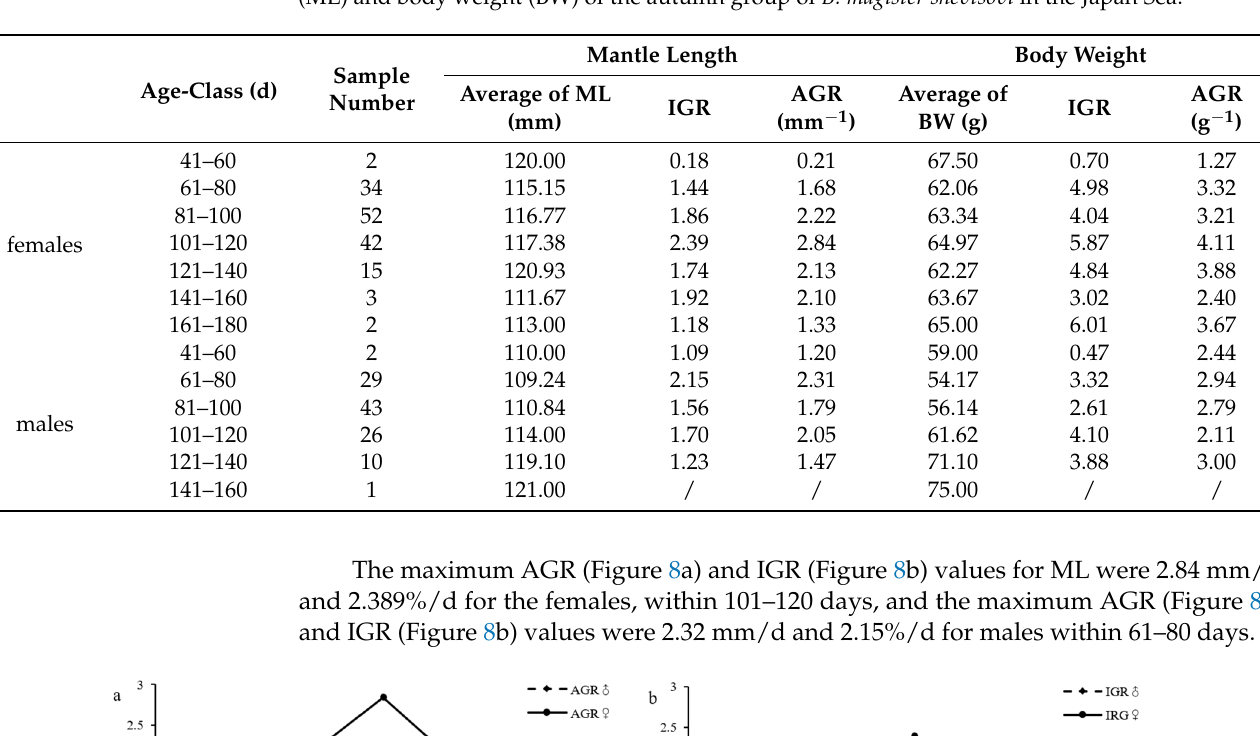
Table 2. Instantaneous relative growth rates (IGRs) and absolute growth rate (AGR) for mantle length (ML) and body weight (BW) of the autumn group of B. magister shevtsovi in the Japan Sea.